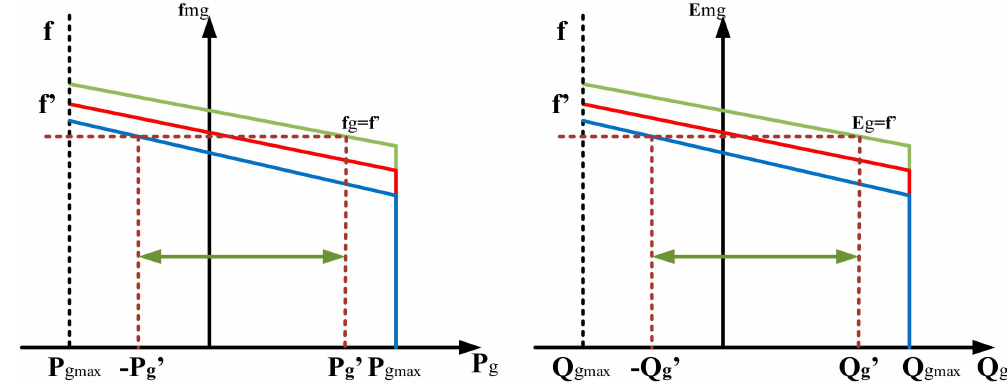
Figure 8. Characteristics of the tertiary control method.